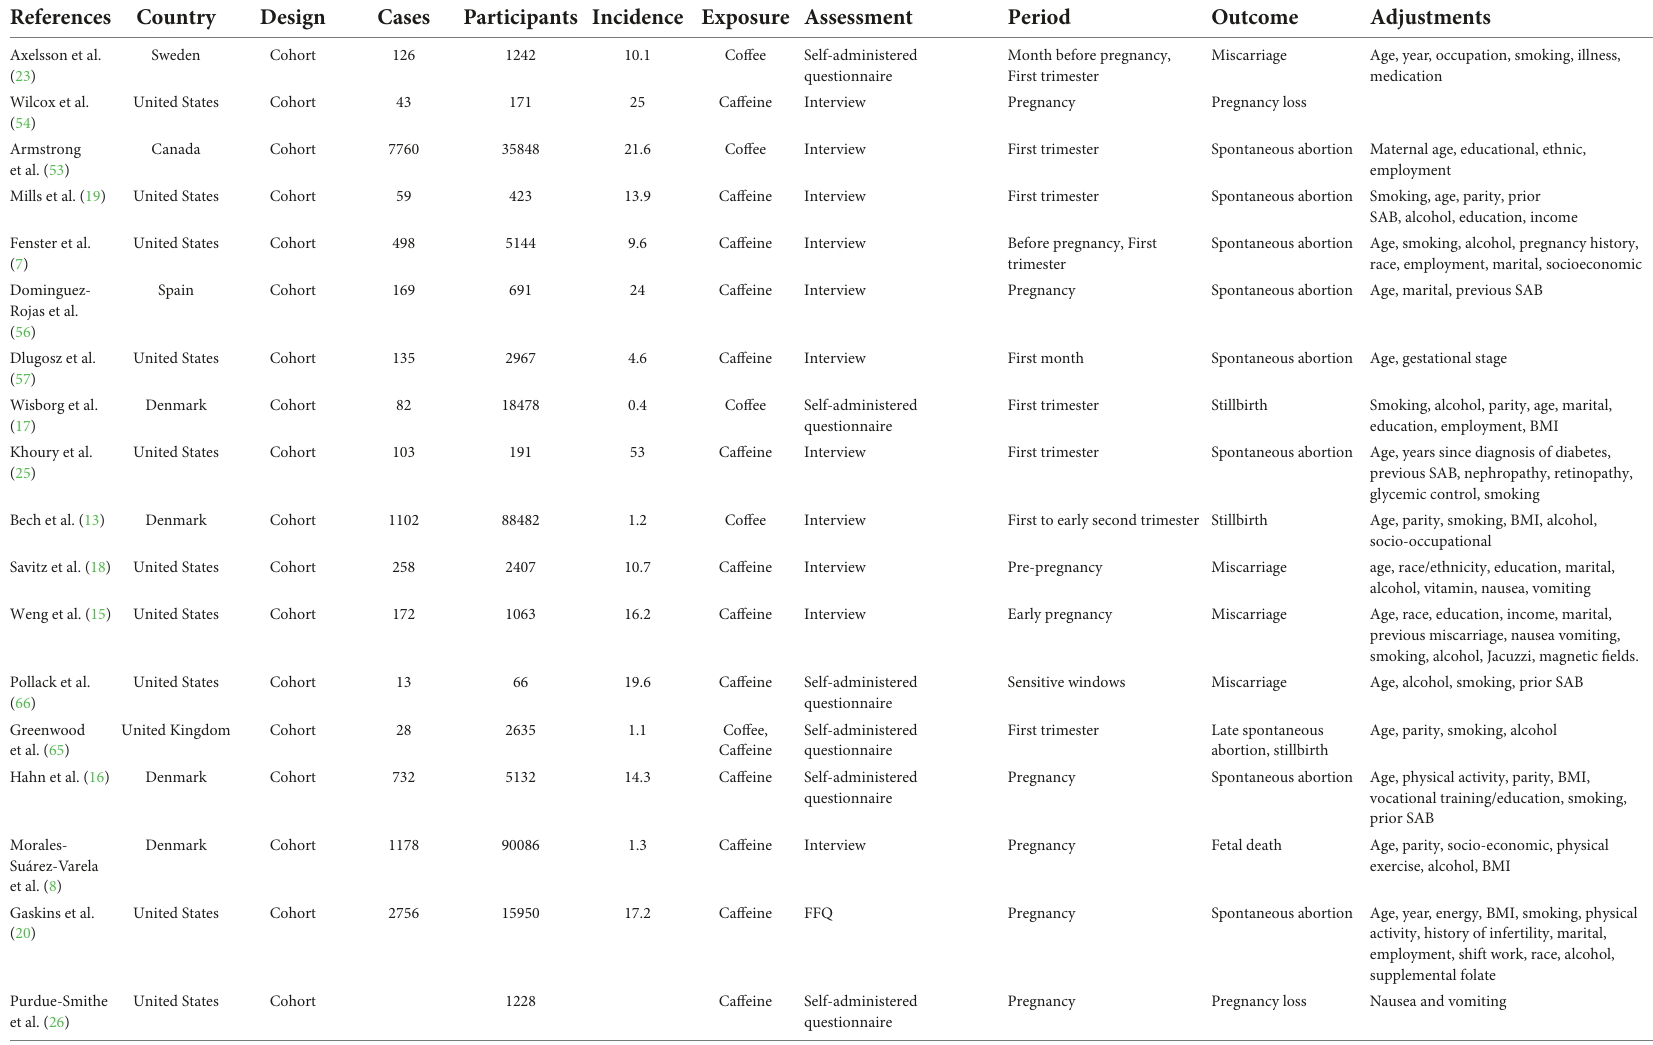
TABLE 1 Characteristic of included cohort studies.